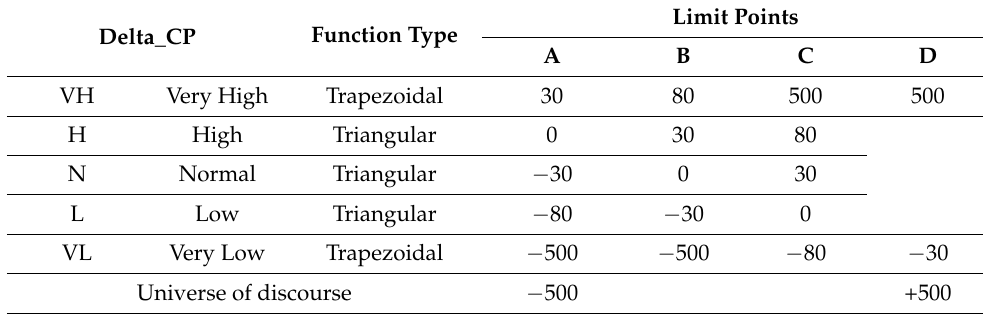
Table 1. Membership functions for variable delta_CP ( ∆ CP ).